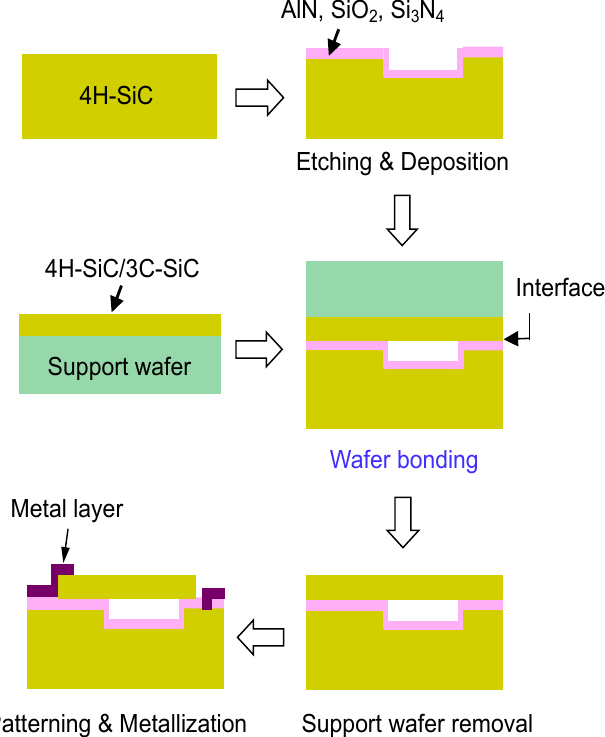
Figure 1. A simplified schematic process to fabricate the all-silicon carbide (SiC) capacitive pressure sensor via wafer bonding.